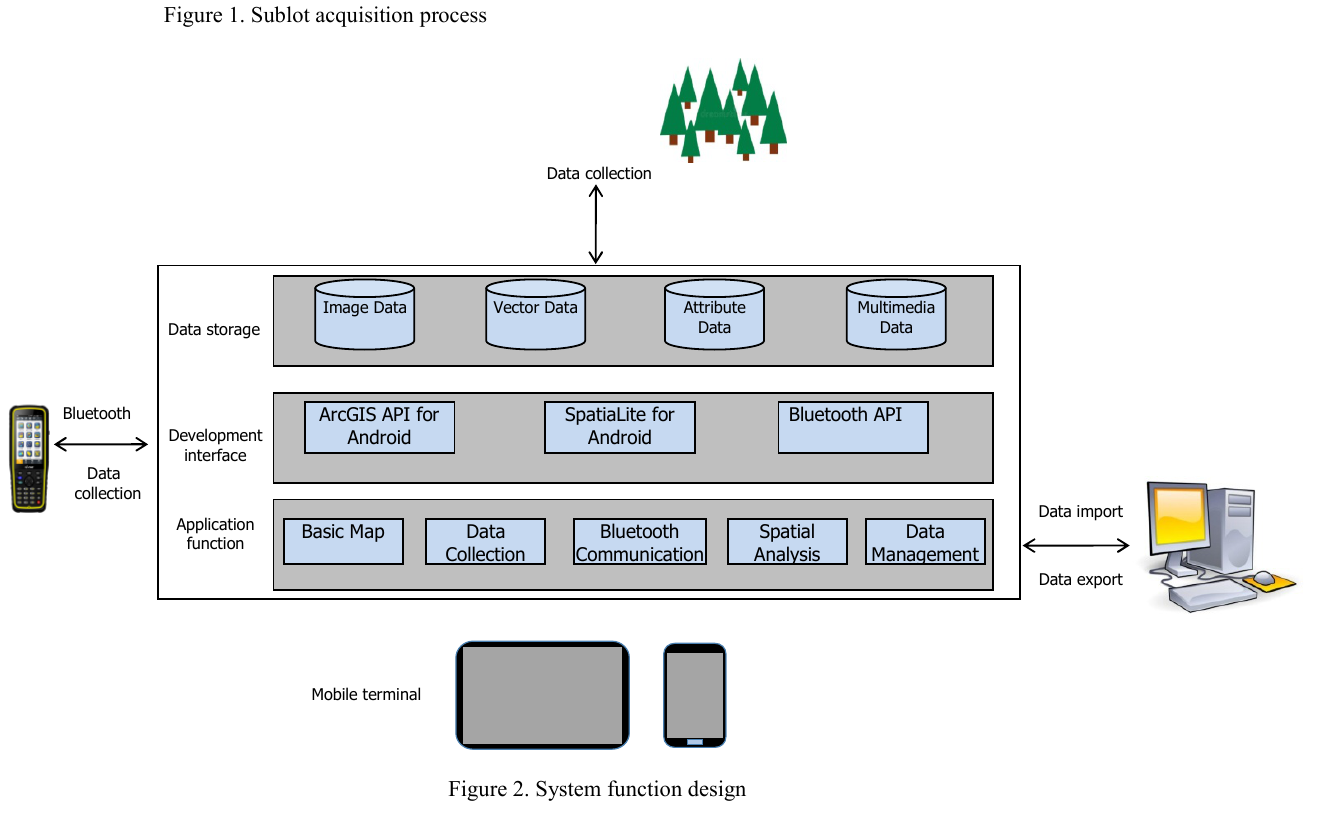
Figure 1. Sublot acquisition process